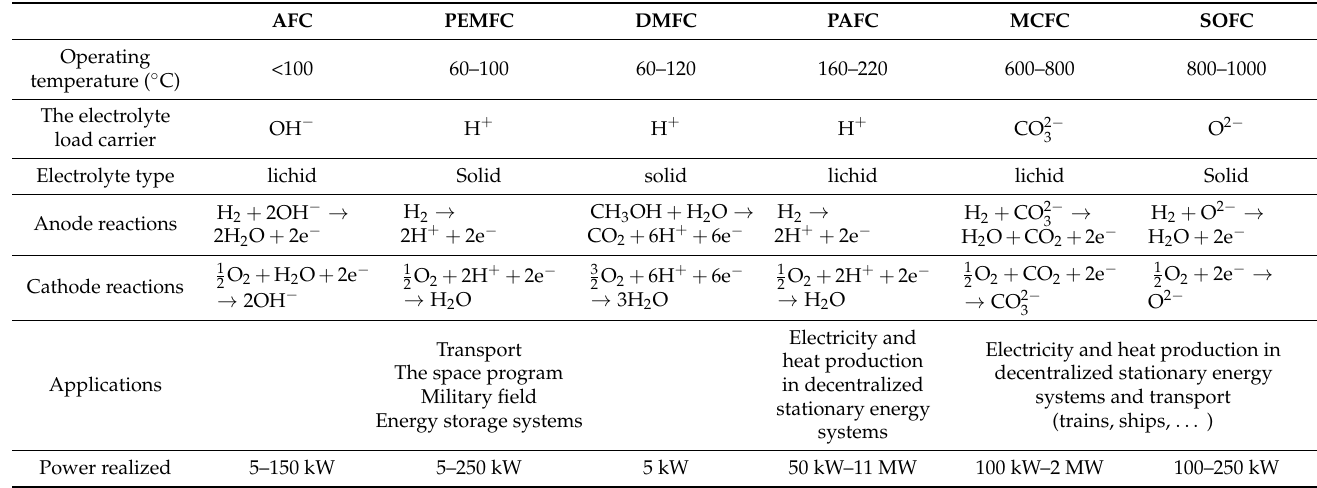
Table 6. Fuel cell type’s comparison [9].